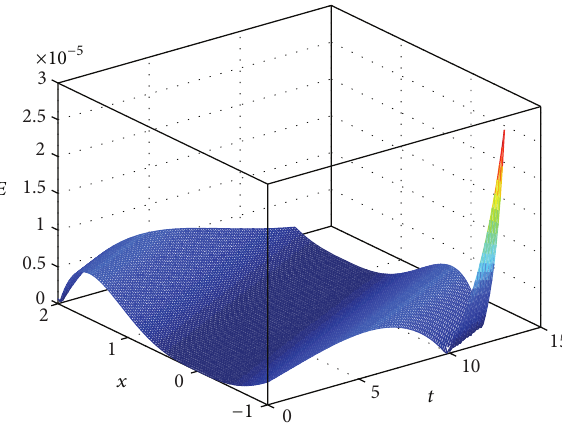
Figure 5: Absolute error of Burgers-type equation, (12), with ] = 10 , 𝜇 = 0.1 , and 𝑐 = 0.1 .